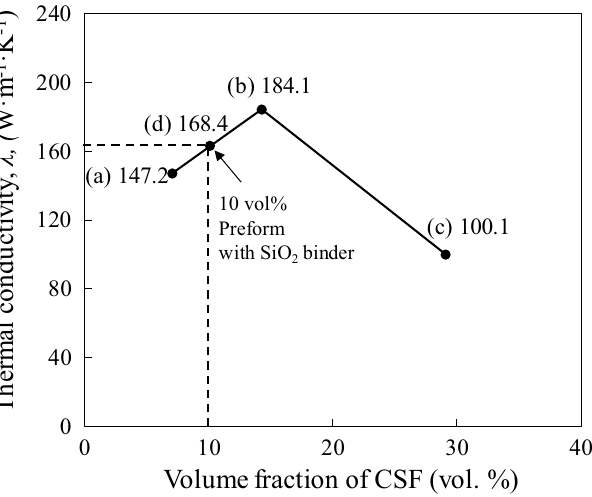
Figure 10. Thermal conductivity of Cu-plated SCF/Al composites by different volume fractions of short carbon